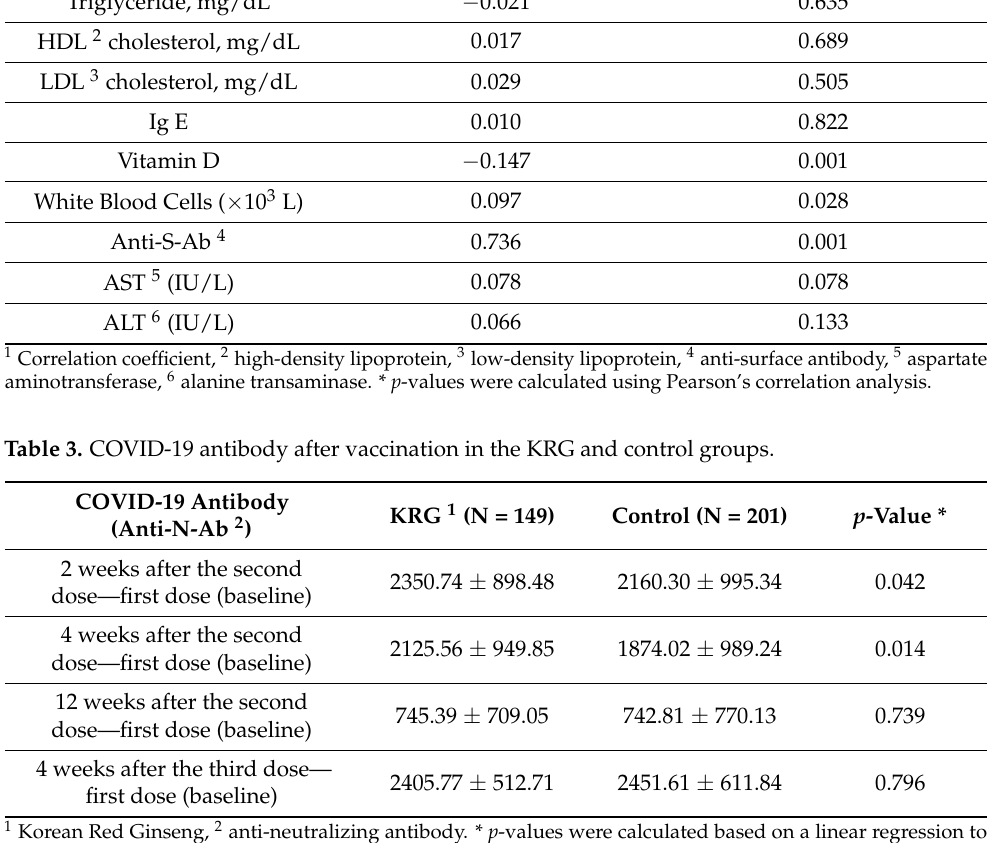
Table 2. Correlations between baseline anti-neutralizing antibody (Anti-N-Ab) and other variables. Variables Age, years